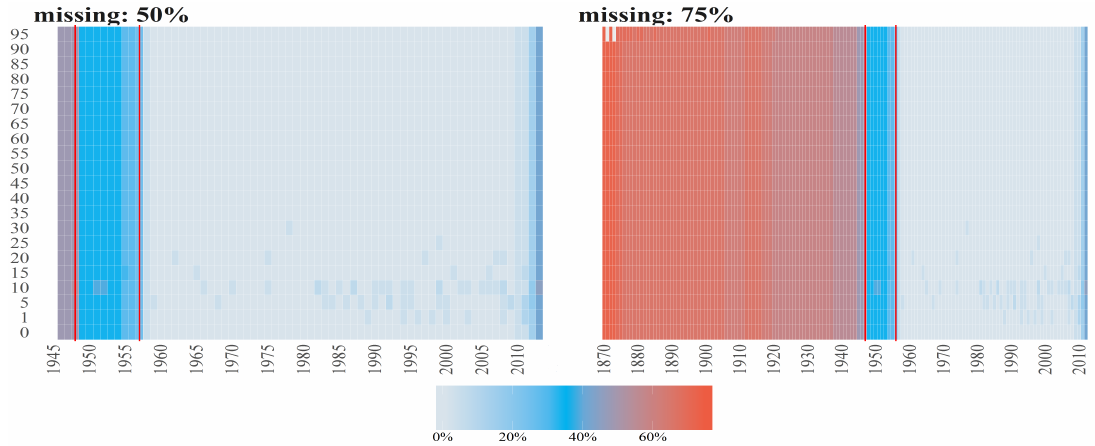
Figure 3. Percentages of missing values (denoted by diffrent colours) per observation for Number of Deaths for Females per age groups (y axis) over time (x axis). The titles of the subplots indicate the case of missing values (50%, 75%). The percentage for a given country and given age group is computed dividing number of missing values by number of countries. Red vertical lines correspond to the starting points in time when the cases 50% and 25% start (from the left to right side on corresponding